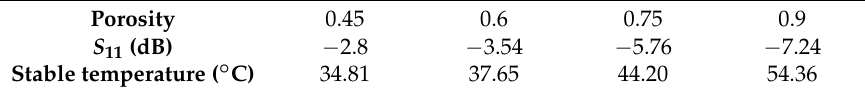
Table 5. The S 11 and temperature of different porosities of silicon carbide.